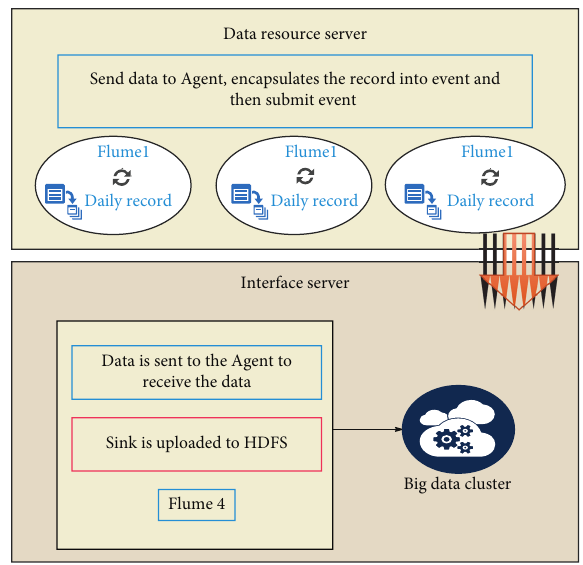
Figure 8: The design idea of Flume data collection.